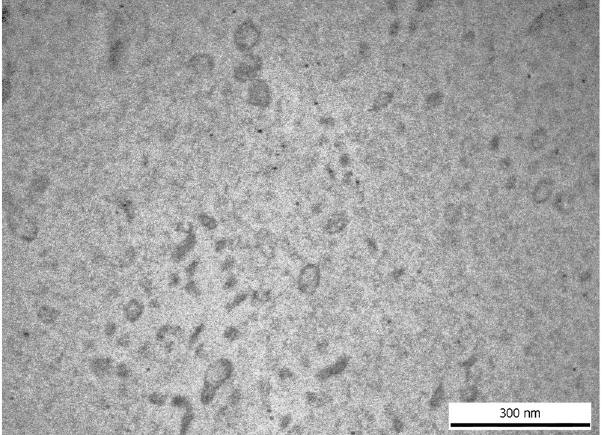
Figure 1. Transmission electron microscopic image of human blood plasma EVs isolated by ultracentrifugation, washed once and submitted to RNAse